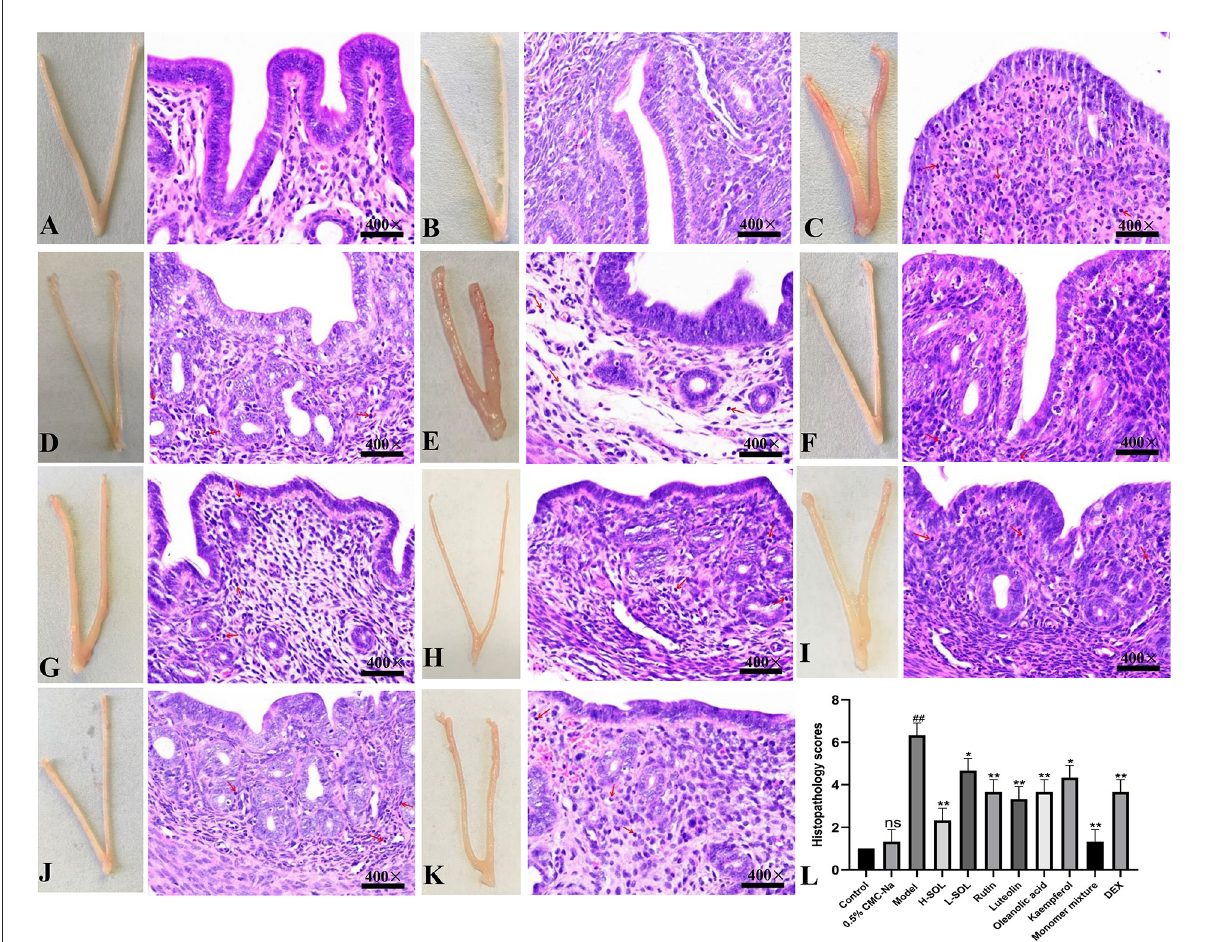
FIGURE6 Morphological and histopathological changes. (A) Control group. (B) 0.5% CMC-Na group. (C) S. aureus group. (D) S. aureus + H-SOL group. (E) S. aureus + L-SOL group. (F) S. aureus + rutin group. (G) S. aureus + luteolin group. (H) S. aureus + oleanolic acid group, (I) S. aureus + kaempferol group, (J) S. aureus + monomer mixture group. (K) S. aureus + DEX group (Hematoxylin and eosin staining, magnification 400 × , arrows: inflammatory cells). (L) Histopathology scores ( ## p < 0.01, ns vs. control group; * p < 0.05, ** p < 0.01 vs. model group; ns, no significant